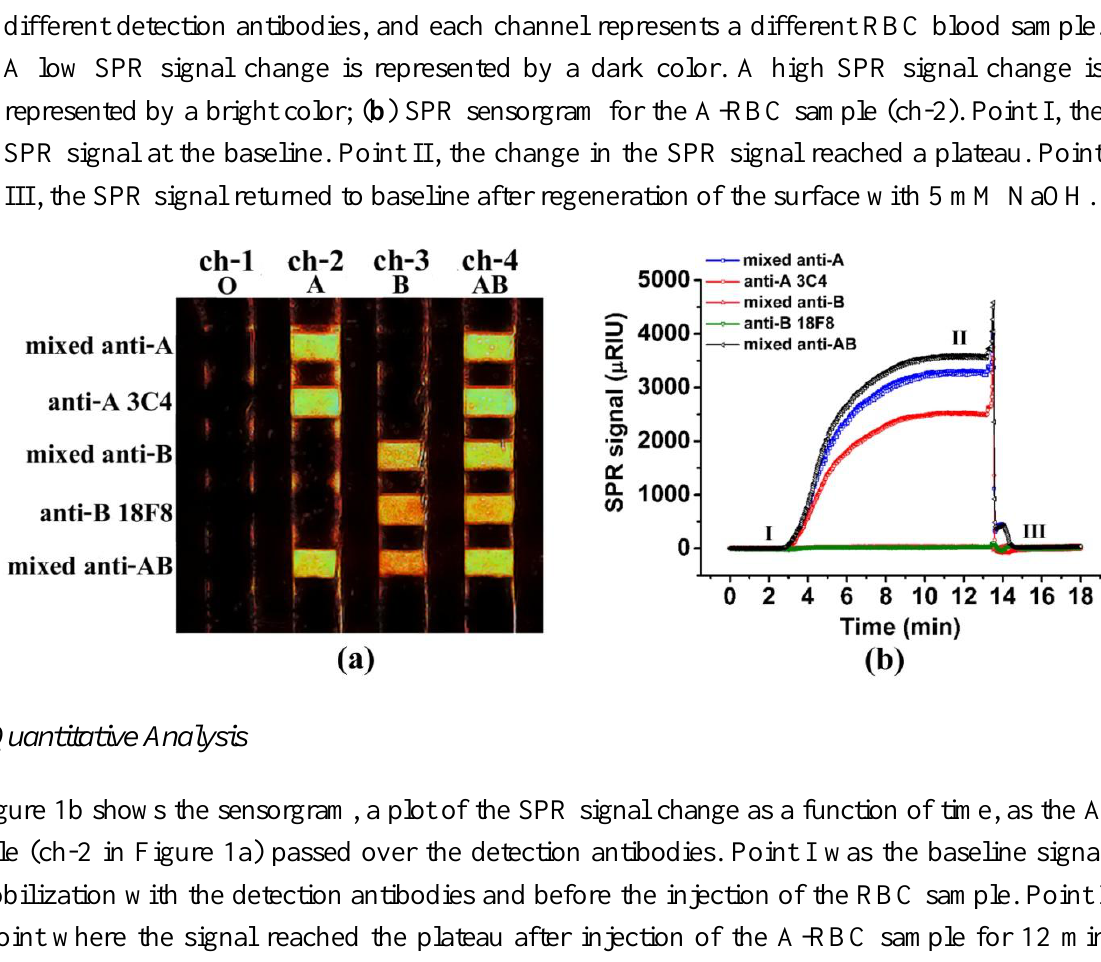
Figure 1. ( a ) An SPR image of the antibody array. Each row was immobilized with five different detection antibodies, and each channel represents a different RBC blood